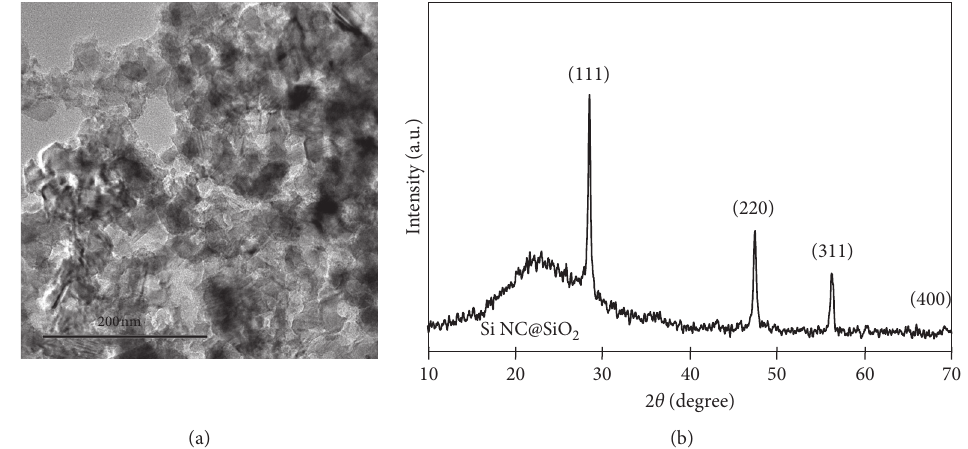
Figure 2: Transmission electron microscopy (TEM) image of Si NC@SiO